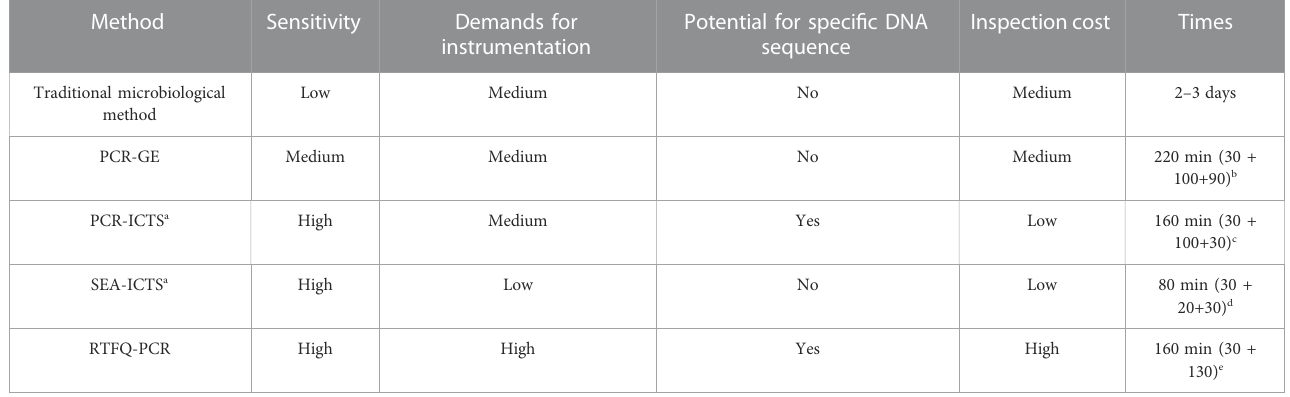
TABLE 4 Parameters comparison of methods used for detection of Klebsiella pneumoniae of